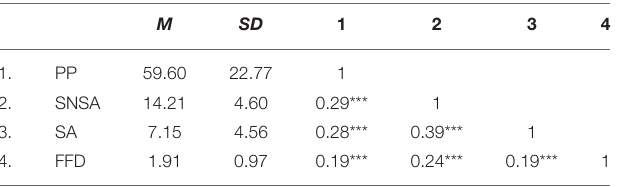
TABLE 1 | Descriptive statistics and correlations among